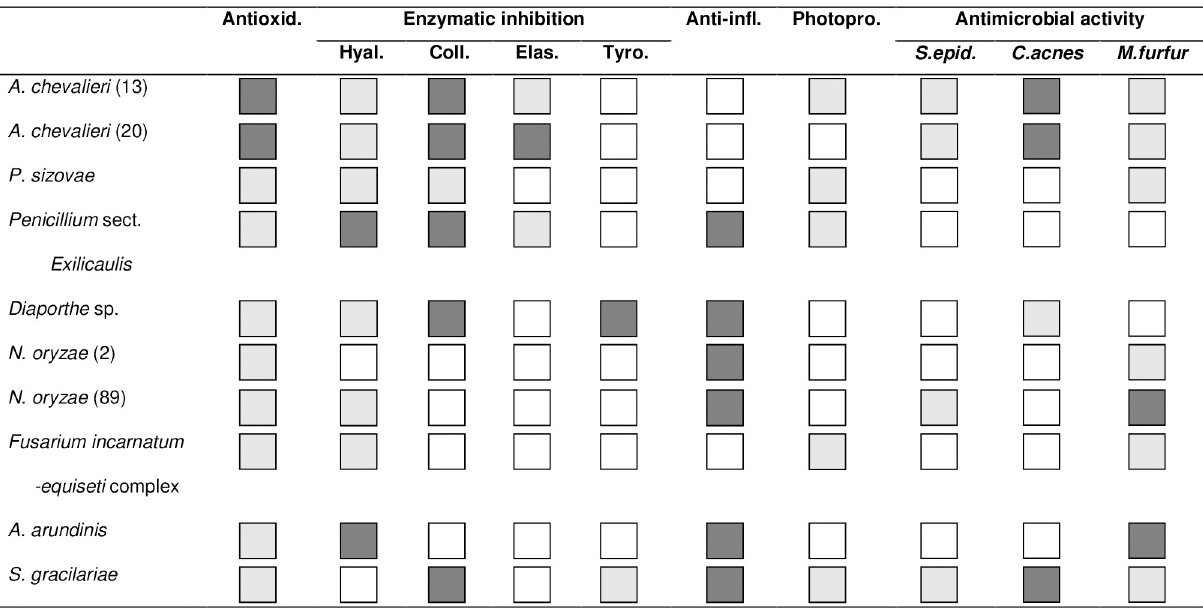
Fig 9. Overall overview of antioxidant, enzymatic inhibitory, anti-inflammatory, photoprotective and antimicrobial capacities of the extracts obtained from the eight marine endophytic fungi associated with Halopteris scoparia . Dark grey and grey squares illustrate strong and weak bioactive potencies, respectively, and white squares, no biological activity